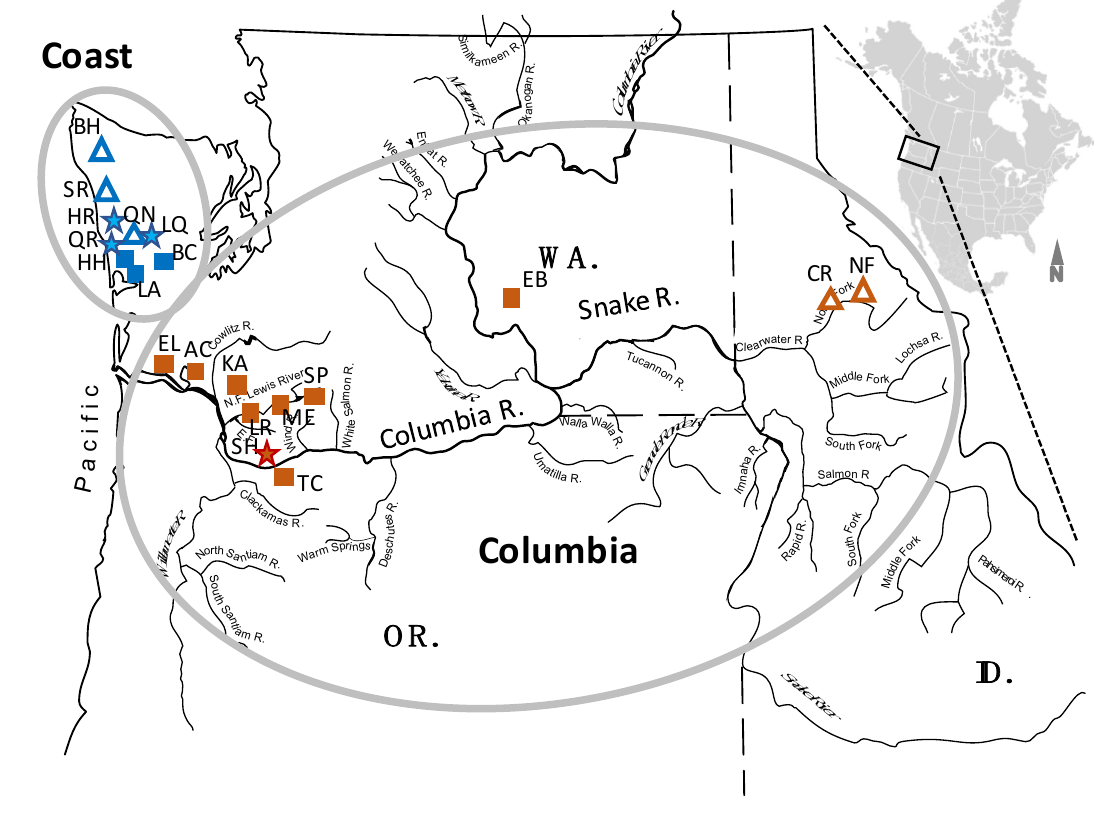
Figure 1. The Washington coast and Columbia regions (gray ovals) and collection sites of IHNV viruses investigated in this study. The Columbia River (mainstem and selected tributaries shown) forms part of the boundary between Washington and Oregon states, and drains all eastern rivers shown. Its largest tributary is the Snake River, which extends into Idaho. The coastal river region contains numerous smaller rivers that drain directly to the Pacific Ocean. Locations of origin for IHNV isolates in this study are indicated by symbols according to which emergence event they were related to; see legend. Blue-labeled locations are in the coastal region, while orange-labeled locations are in the Columbia region. Abbreviations for specific virus collection sites are defined in Table S1.